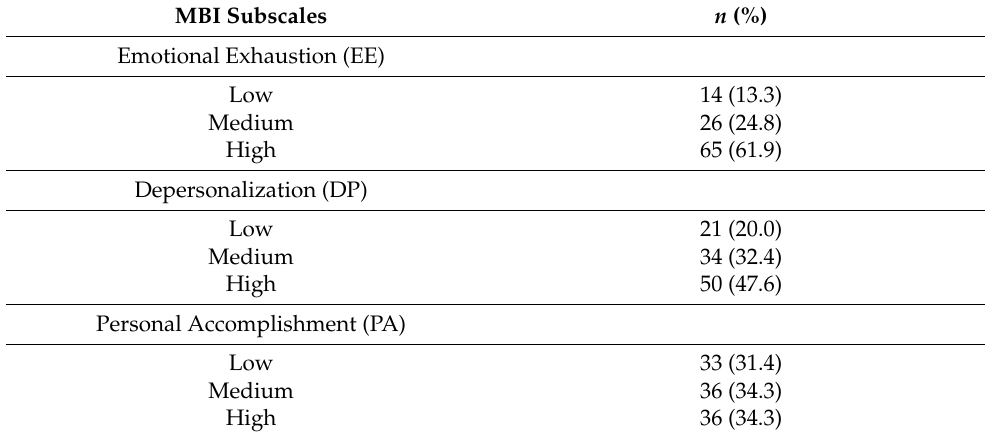
Table 2. Burnout levels evaluated with Maslach Burnout Inventory for healthcare staff.